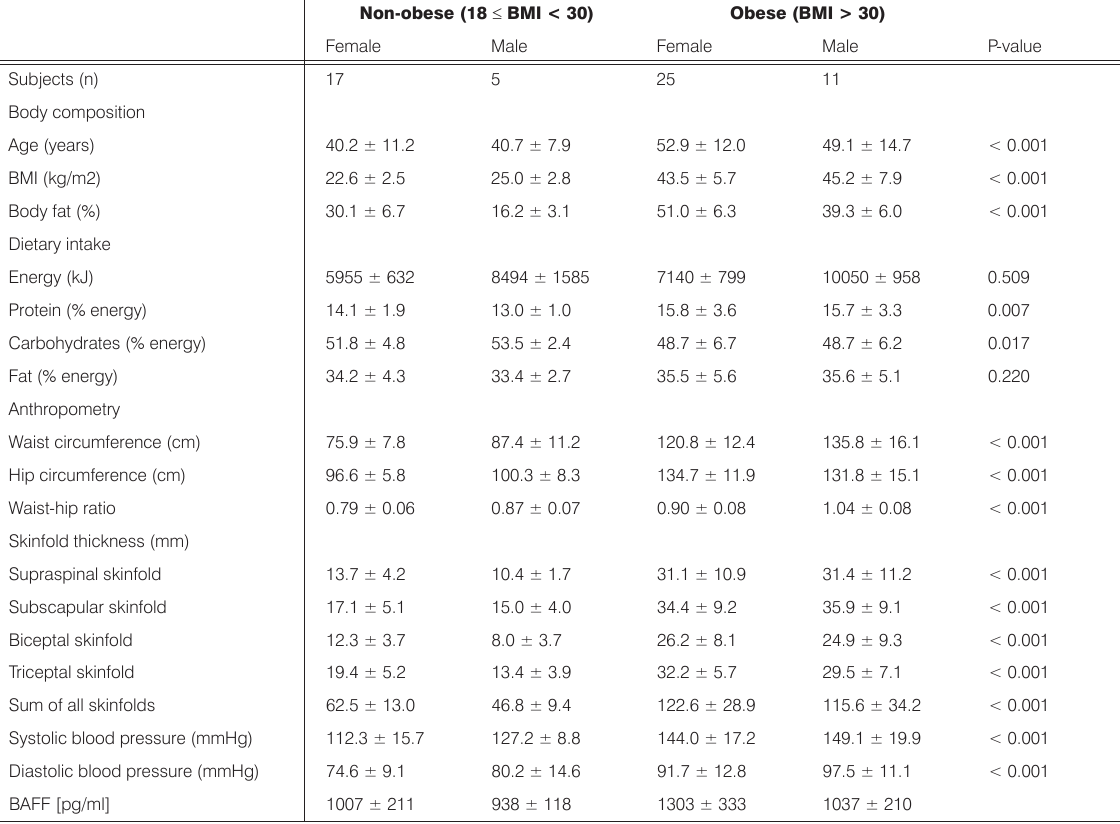
Table 1. Clinical, anthropometric and nutritional data in the obese and non-obese cohorts